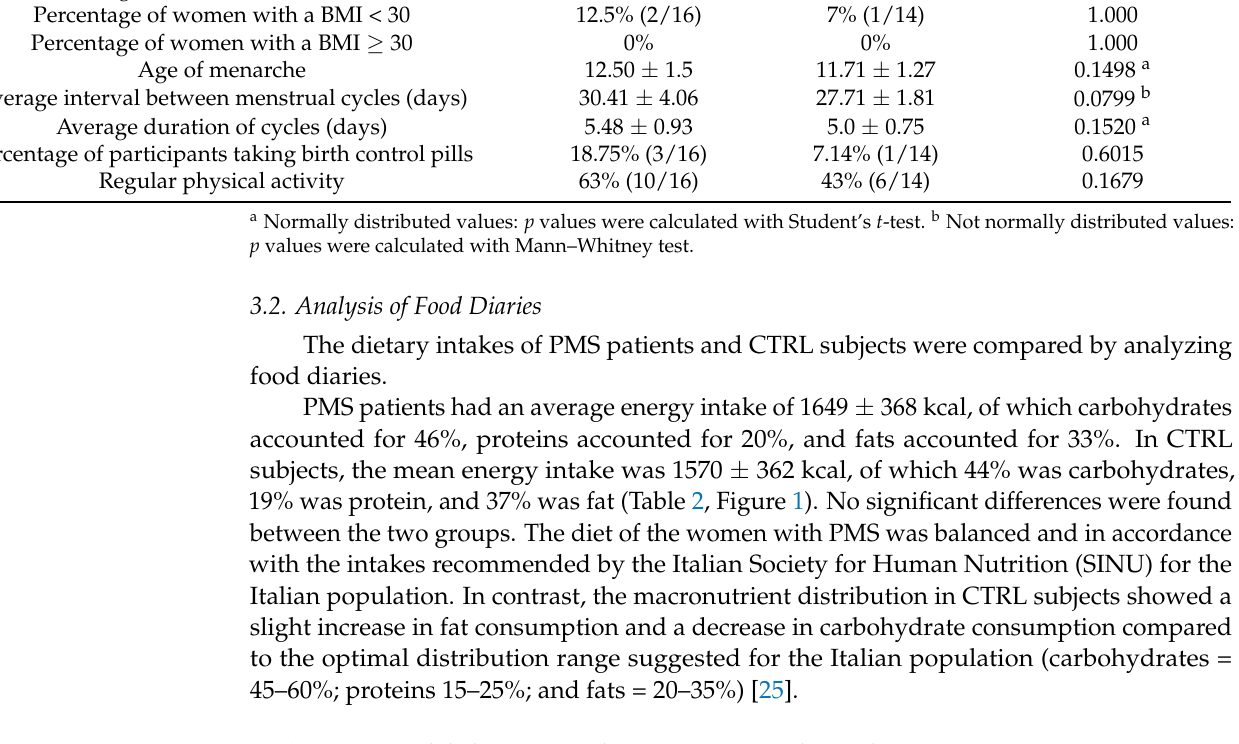
Table 2. Estimated daily energy and macronutrient intakes in the participating women.